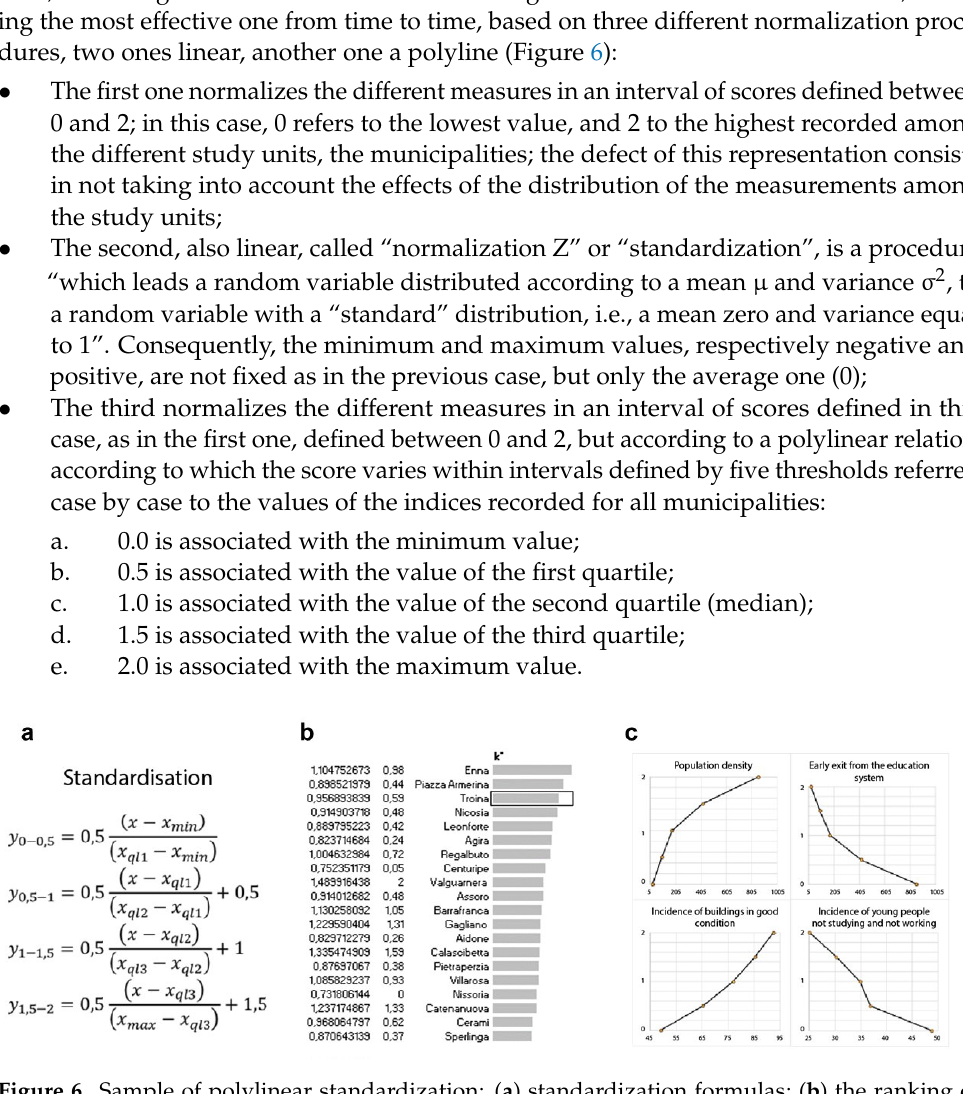
Figure 6. Sample of polylinear standardization: ( a ) standardization formulas; ( b ) the ranking of municipalities based on k*; ( c ) indicators normalized according to the standardization formulas.